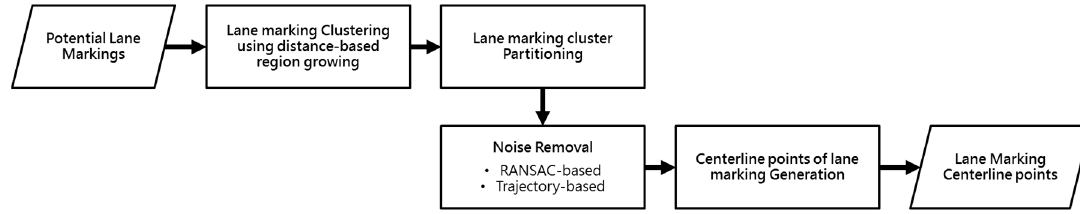
Figure 14. Lane marking centerline derivation framework (adapted from Ravi et al. [18]).